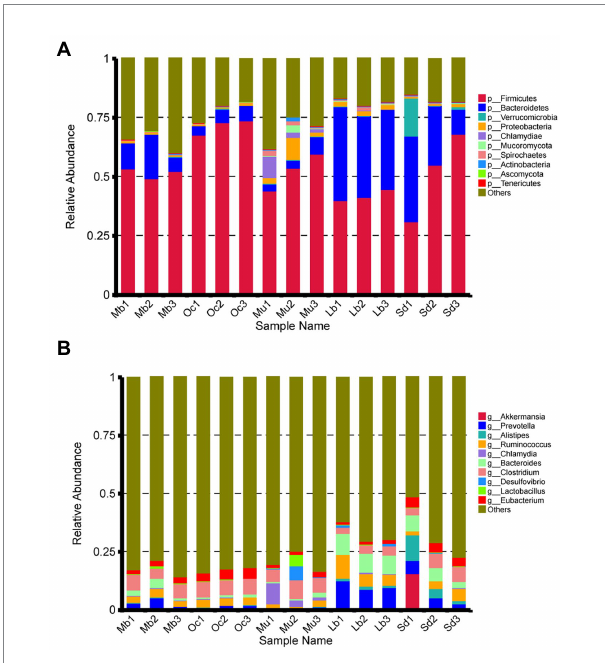
FIGURE 2 Composition of gut bacterial communities under the (A) phylum and (B) genus level among the Mb, Oc, Mu, Lb, and Sd